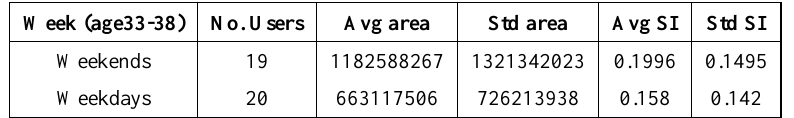
Table 8. Average and standard deviation of area and shape index of users between 33-38 based on days of the week.